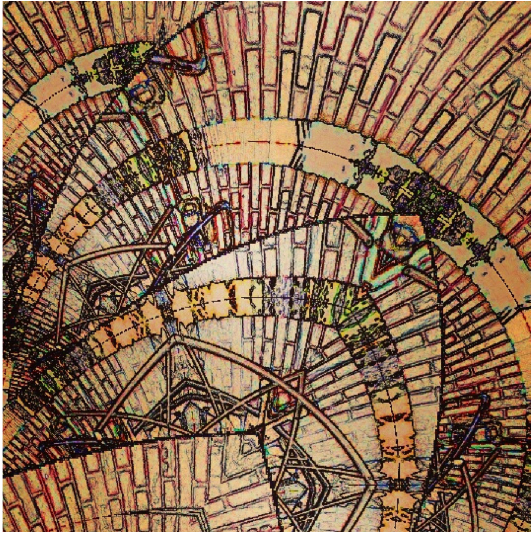
Figure 4 | “Architecture Dream”.